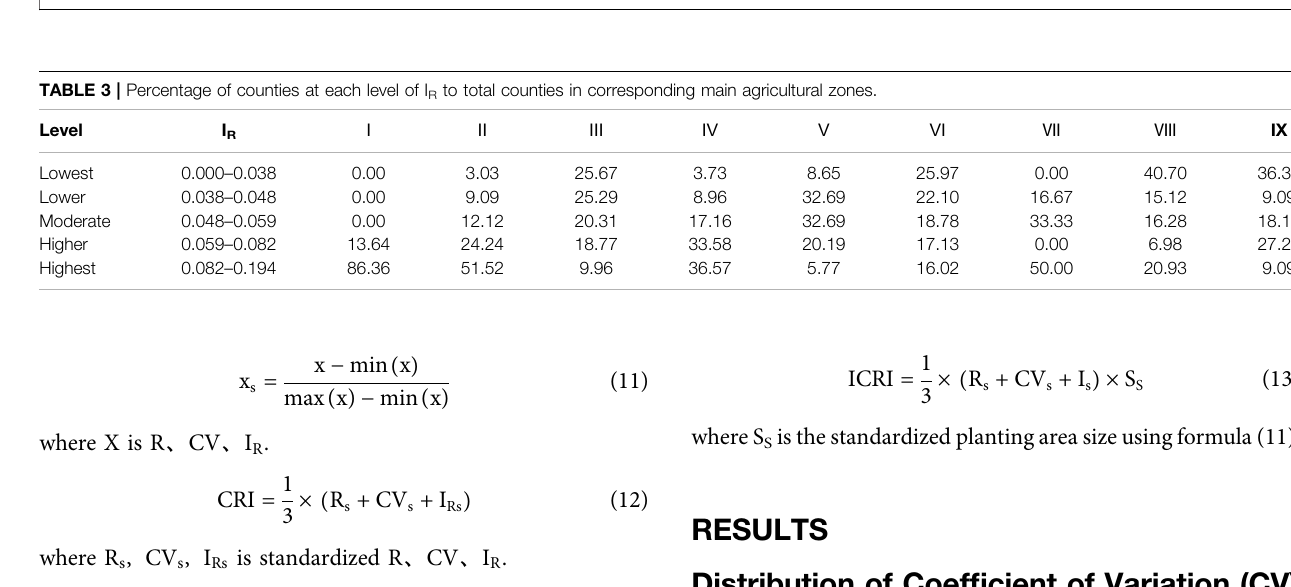
FIGURE 5 | Distribution of risk index of wheat for main production regions in China from 1981 to 2010.